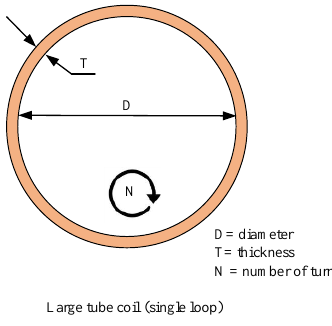
Figure 2. The shape of STLC.